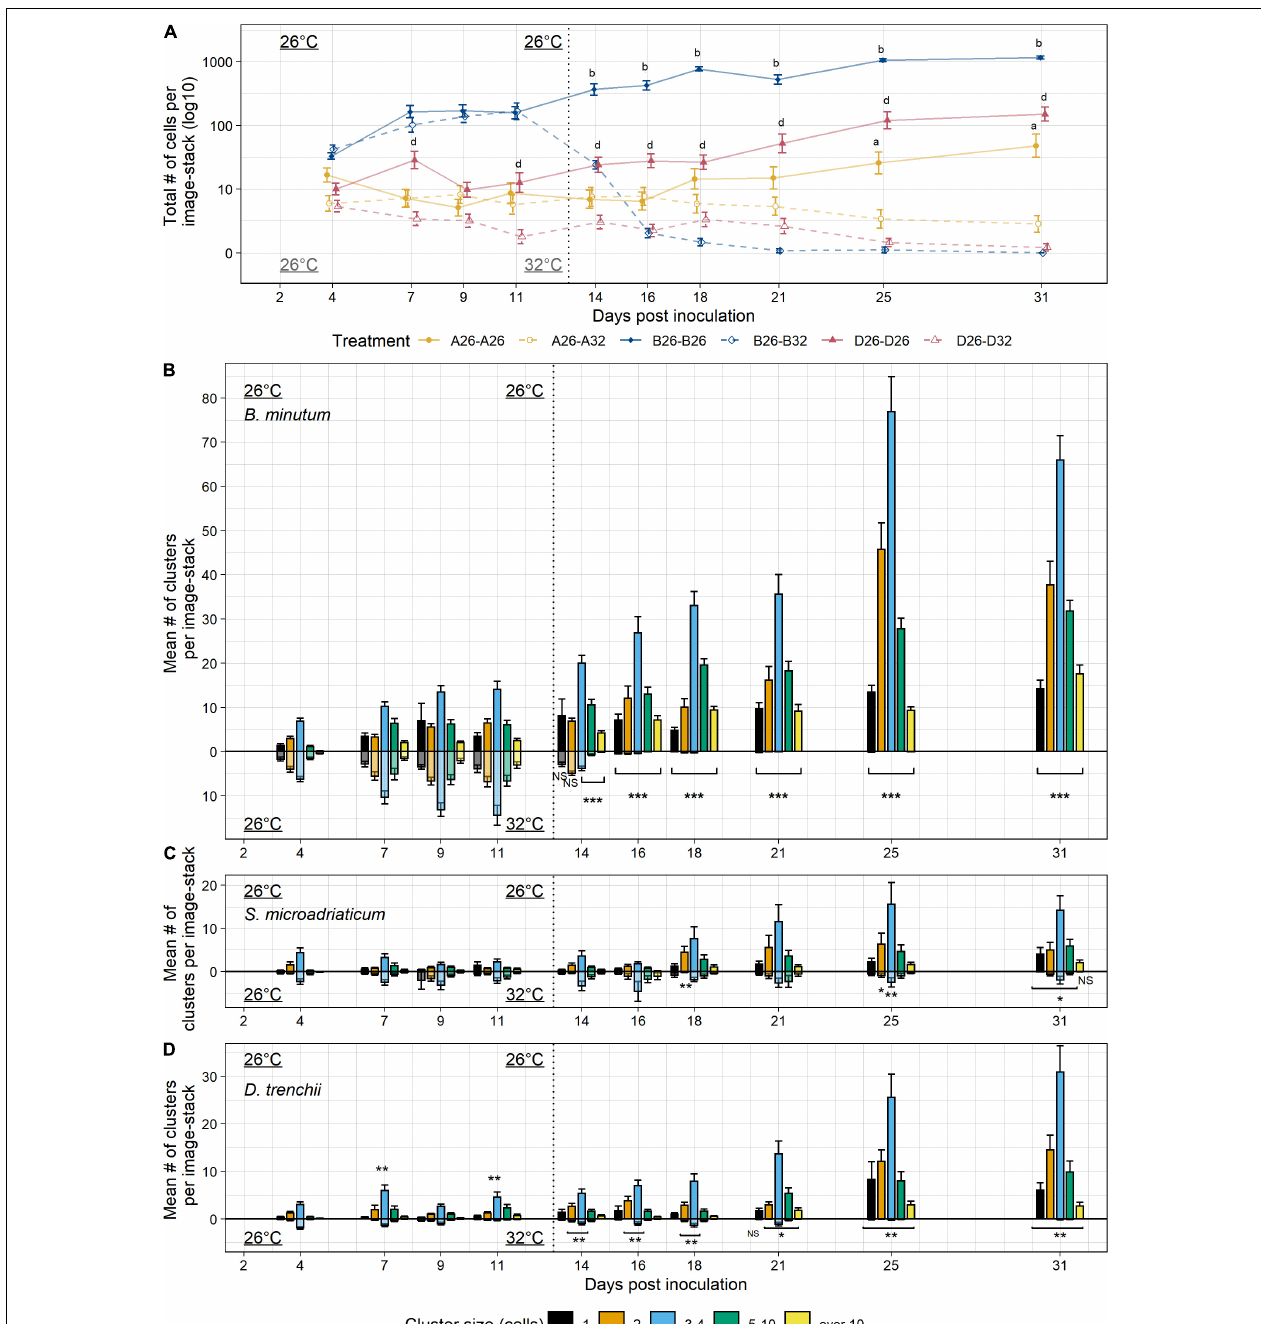
FIGURE 4 | Colonization by B. minutum , S. microadriaticum , and D. trenchii over 4 weeks at 26 and 32 ◦ C. (A) Bleached Aiptasia polyps were colonized with one of three species of algal symbionts: B. minutum , S. microadriaticum , and D. trenchii and subjected to a temperature treatment of a constant 26 ◦ C or a temperature shift from 26 to 32 ◦ C to compare colonization and bleaching phenotypes. The total numbers of cells per sample image-stack were measured over a 4 week period for each symbiont (3 sample image-stacks per anemone host, 12 anemones per treatment). During the first week both treatments received the same 26 ◦ C temperature treatment to promote colonization. After 7 days, one temperature treatment remained at 26 ◦ C and the other temperature treatment was moved to 32 ◦ C. Aiptasia were inoculated with a concentration of 5 × 10 5 cells • mL − 1 . Y -axis is log 10 transformed for clarity. (B–D) The mean number of cell clusters per image-stack were binned into discrete cell cluster sizes measured over 3 weeks for each symbiont species, (B) B. minutum , (C) S. microadriaticum , and (D) D. trenchii . 26 ◦ C treatment for 3 weeks is shown on the positive y -axis, while 26–32 ◦ C treatment is shown on the negative y -axis, reflected across the x -axis for comparison. The beginning of the difference in treatment conditions is indicated by a vertical dotted line at 13 days post-inoculation. Error bars signify standard error for the total abundance of clusters or cells. Letters (A) and asterisks (B–D) indicate significant differences between temperature treatments within symbiont species at each timepoint by Tukey post hoc tests (* p < 0.05, ** p < 0.01, *** p < 0.001).